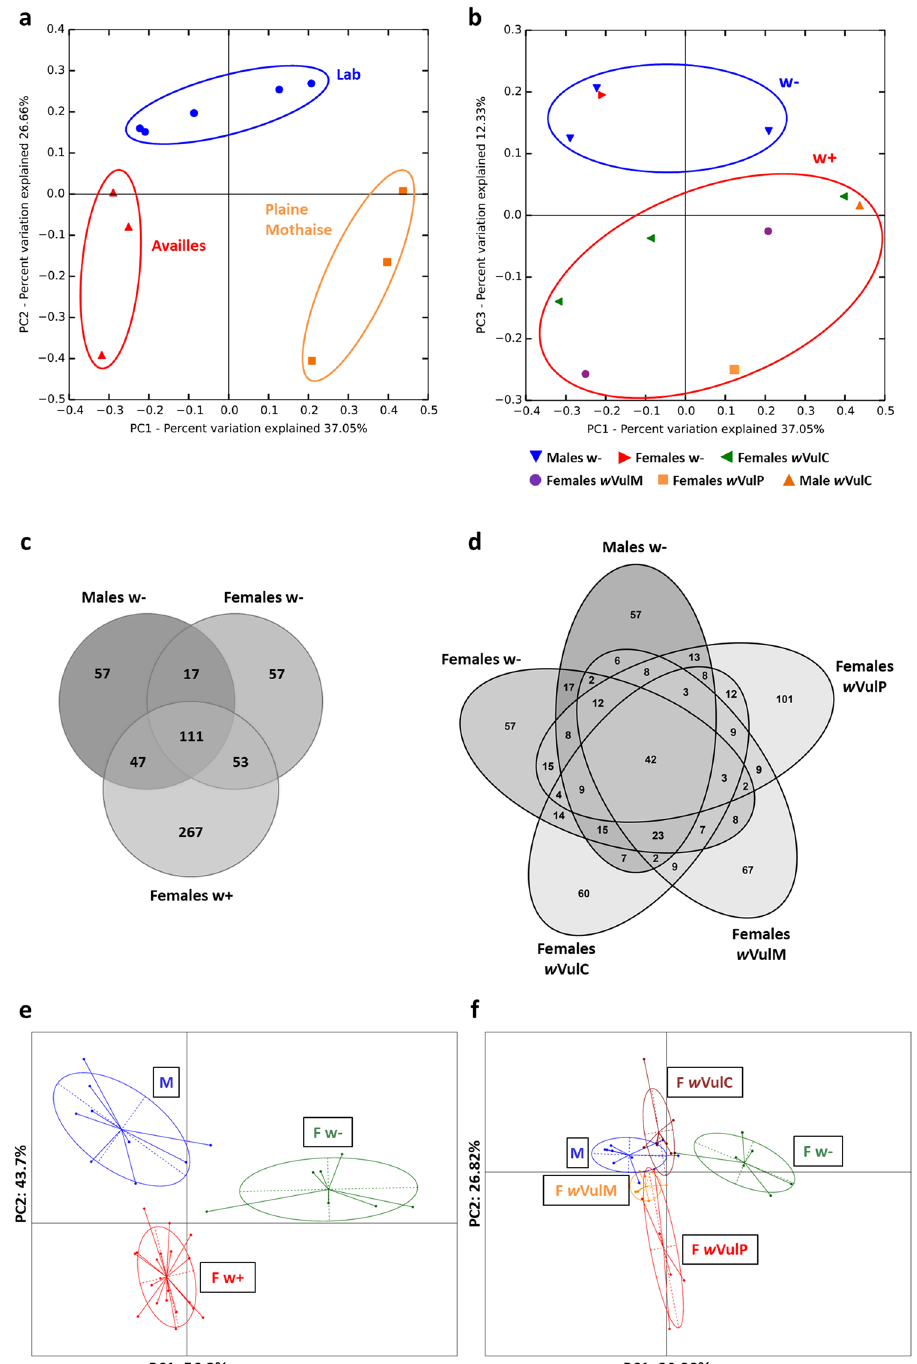
Figure 3. Impact of Wolbachia infection on microbiota composition. ( a , b ) PCoA based on Bray-Curtis distances showing the impact of host origin ( a ) and Wolbachia infection ( b ) on microbiota composition. Each data point represents the microbiota of a given sample type after merging the sequencing data from five different tissues. ( c , d ) Distribution of OTUs in isopods from laboratory lineages depending on Wolbachia infection (c) and infection with different Wolbachia strains (d ). (e , f ) Between-Class-Analysis of TGGE profiles showing differences in microbiota composition depending on Wolbachia infection ( e ) and infection with different Wolbachi a strains ( f ) for specimens from laboratory lineages. Each data point represents the merged profile from five different tissues of an individual